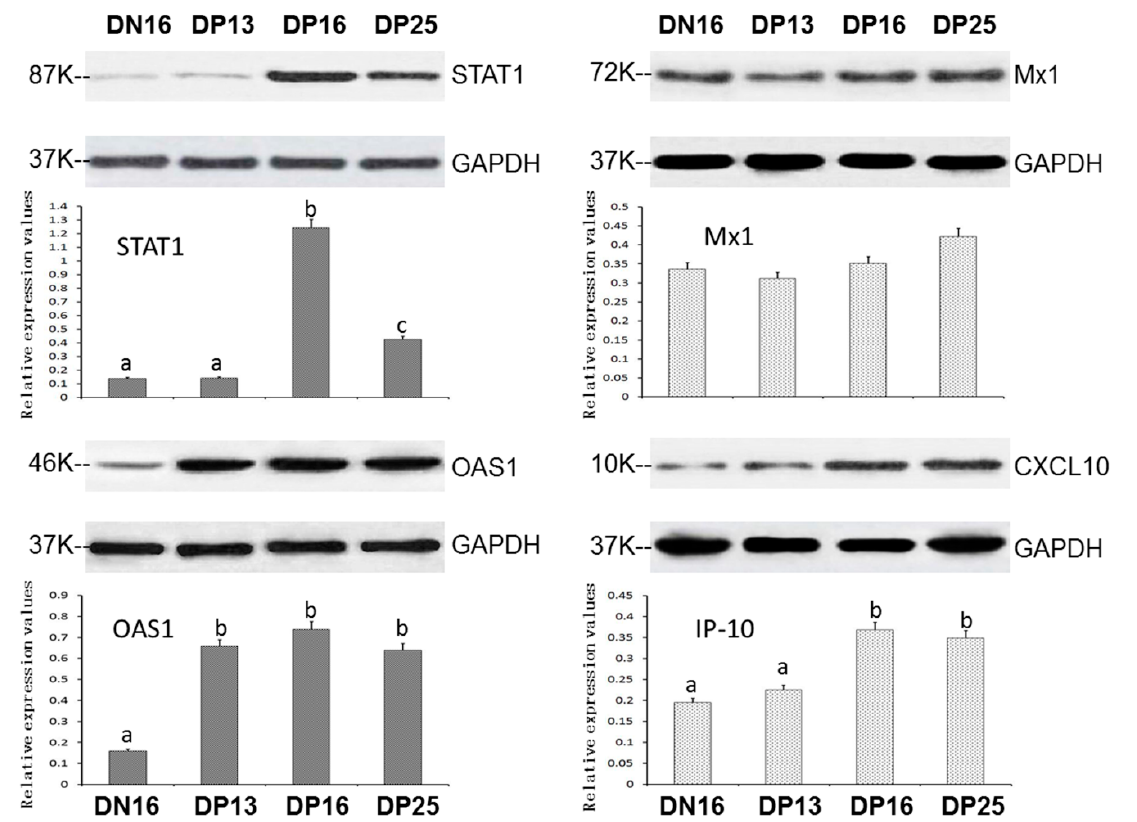
Figure 2. Expression of STAT1, OAS1, Mx1 and CXCL10 proteins in ovine spleens analyzed by western blot. Note: DN16 = Day 16 of the estrous cycle; DP13 = Day 13 of pregnancy; DP16 = Day 16 of pregnancy; DP25 = Day 25 of pregnancy. Significant differences ( p < 0.05) are indicated by different superscript letters within the same color column.